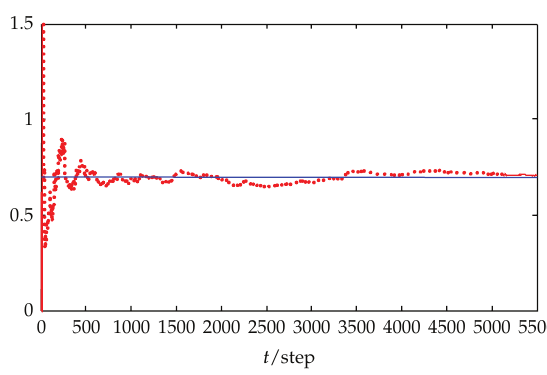
(cid:11) Q ξ 2 (cid:5) t (cid:6) .